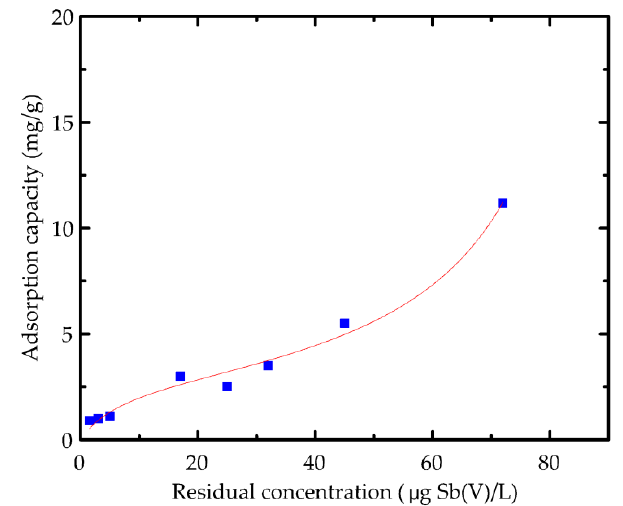
Figure 7. Fitting of Sb(V) adsorption onto FeOOH precipitates (BET model) by using coagulation/precipitation with equimolar Fe(III)/Fe(II); experimental conditions: pH 7, T = 22 ± 1 °C, initial concentrations range 15 –100 μg Sb(V)/L, total iron dose 1 – 10 mg/L.